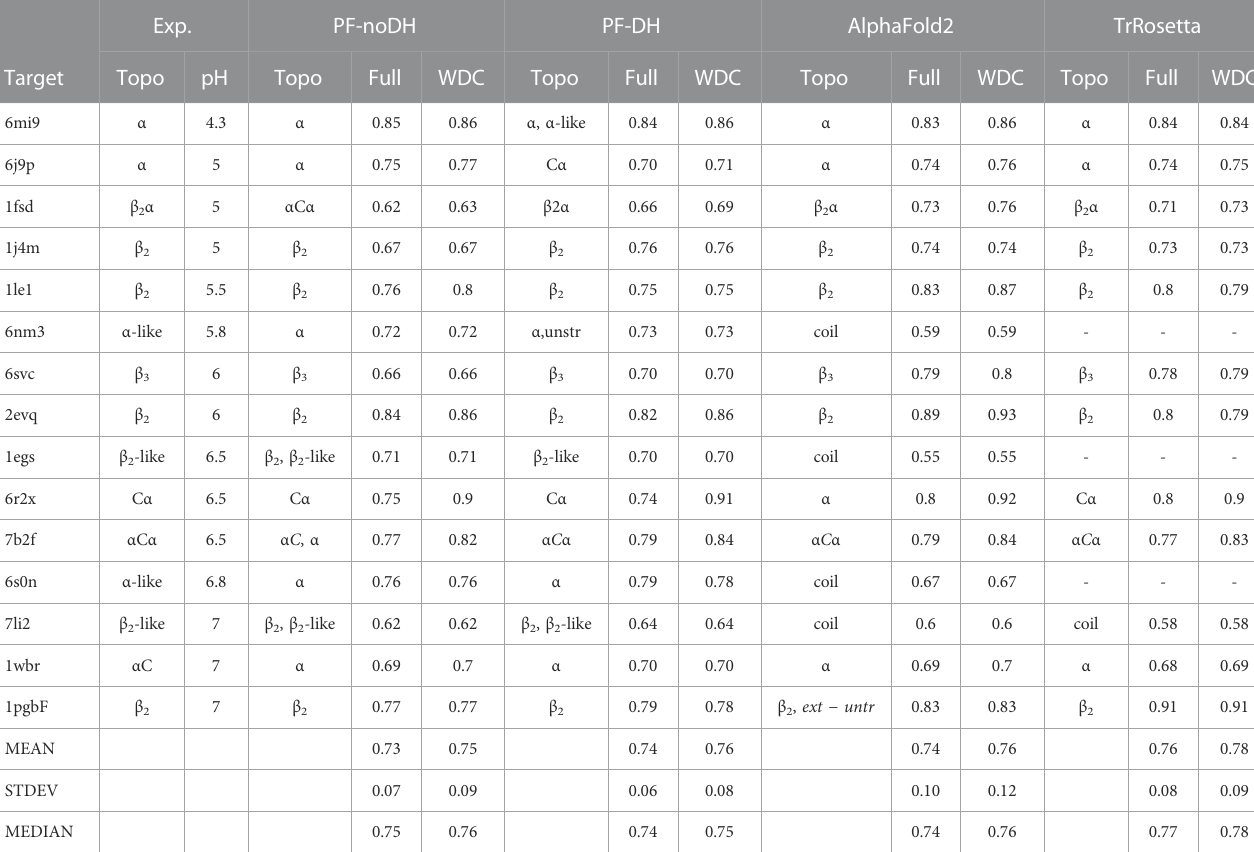
TABLE 3 Performance prediction for structured peptides. Exp.